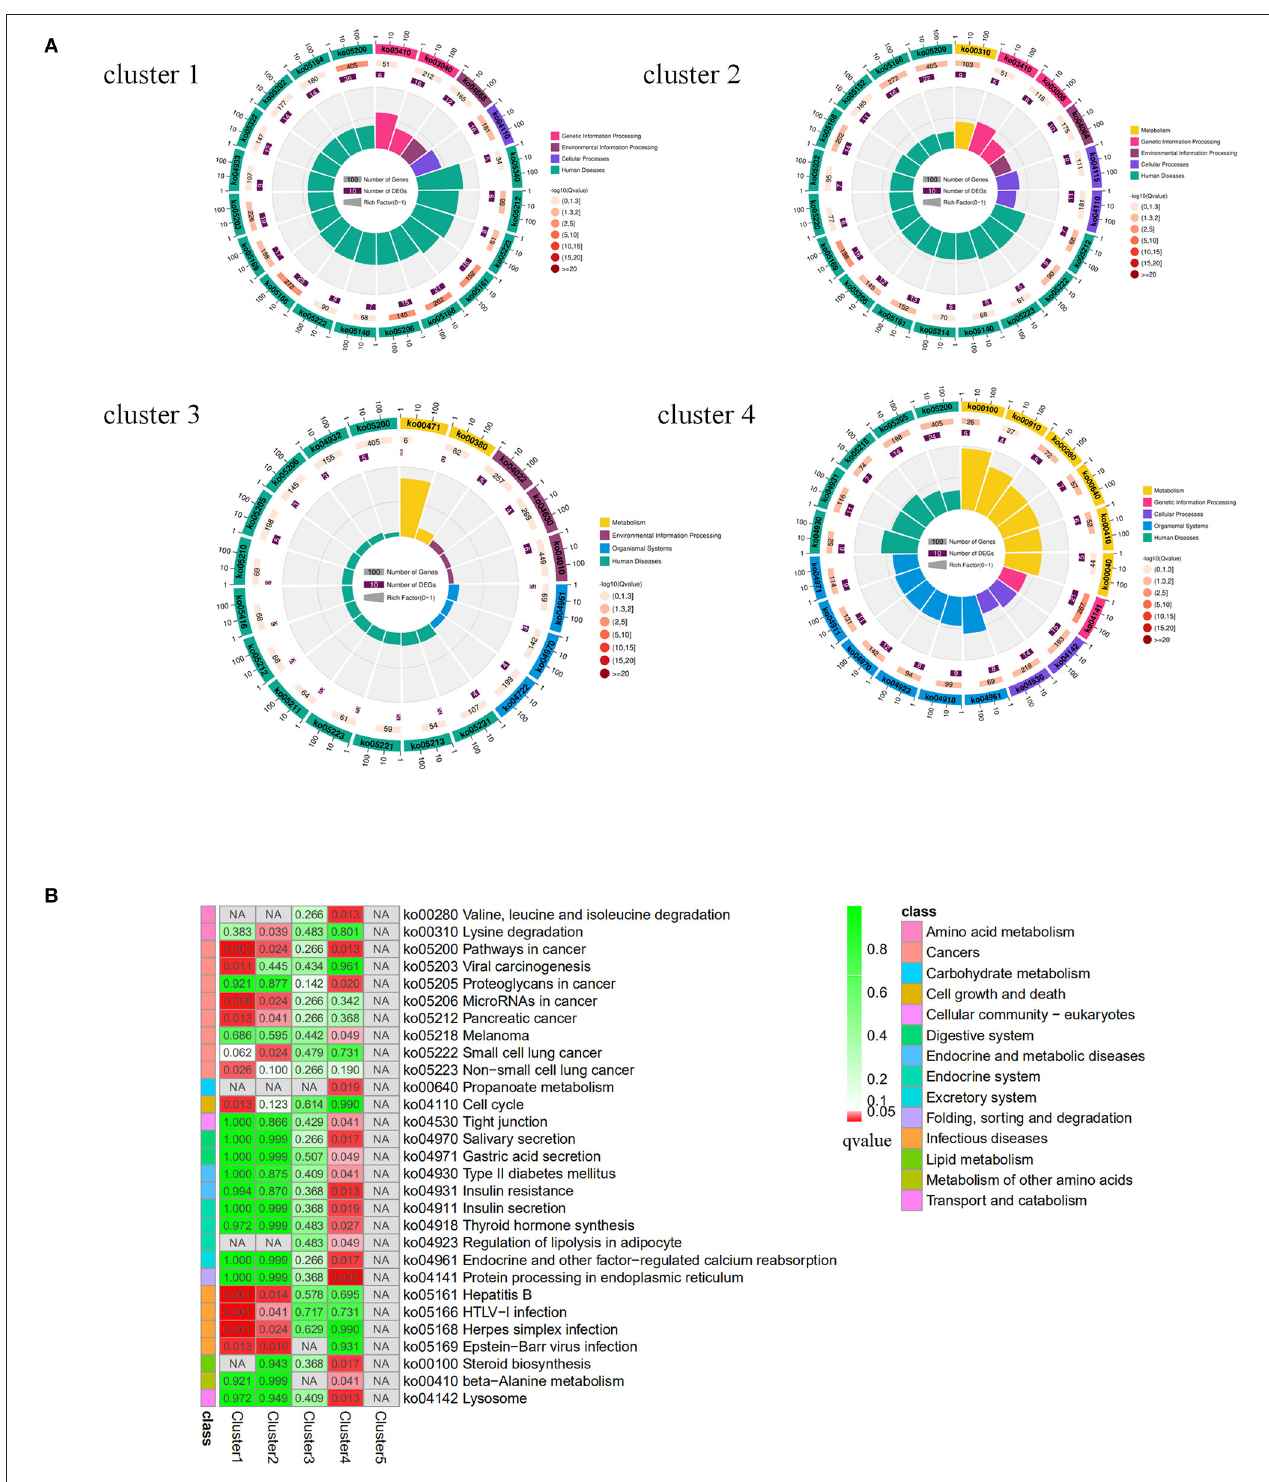
FIGURE 5 | KEGG enrichment analysis of target genes predicted by different miRNA expression patterns. (A) Circular map of KEGG enrichment analysis results of target genes predicted by miRNAs with different expression patterns. (B) Comparison of target genes enriched pathways that were predicted by miRNAs with different expression